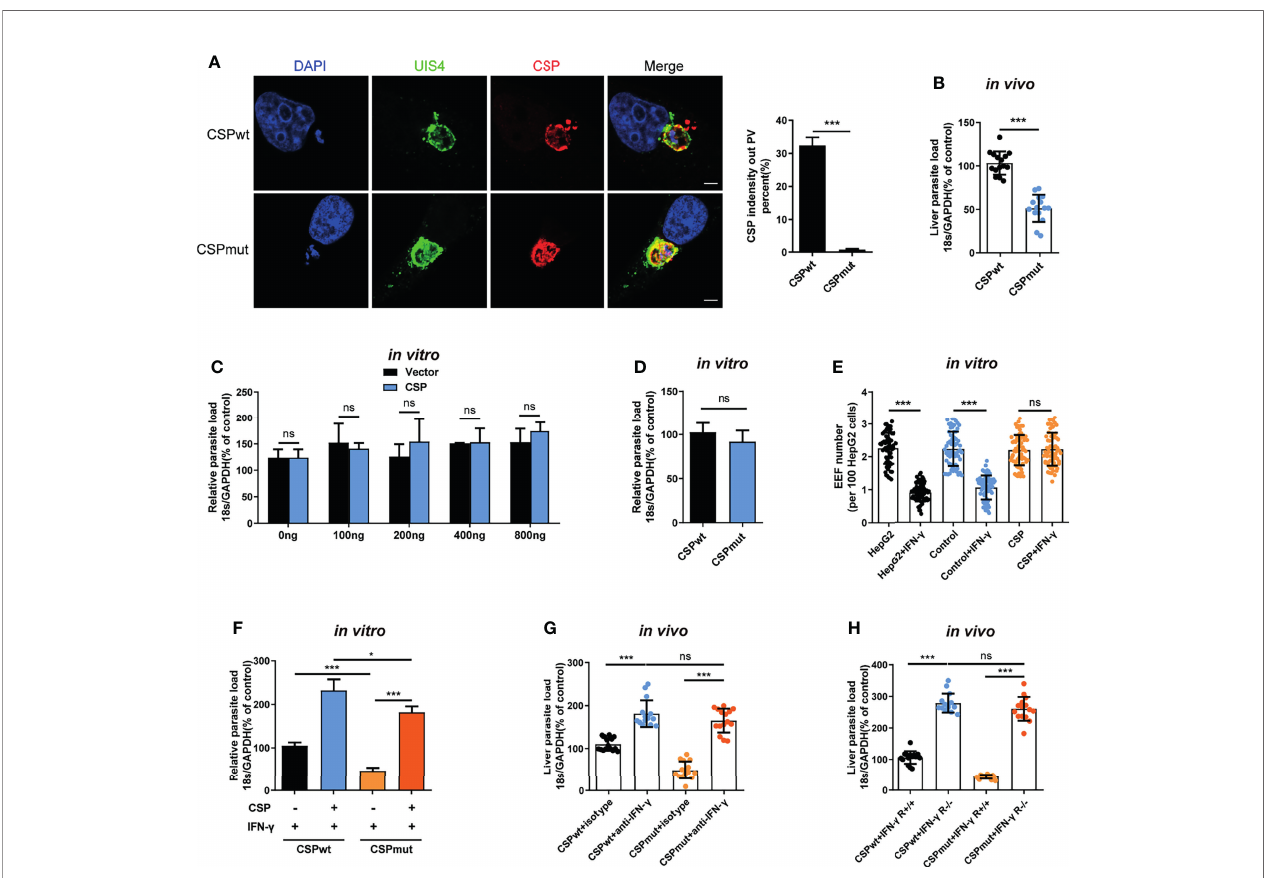
FIGURE 1 | CSP translocated into cytoplasm of hepatocyte mediates the resistance to the killing of EEFs by IFN- g . (A) After 1.2 × 10 5 HepG2 cells were incubated with 4 × 10 4 CSP wt and CSP mut P.b ANKA sporozoites for 24 h, then cells were stained with anti-UIS4, anti-CSP and DAPI. Translocation of CSP of EEFs (n=60) from the PV into HepG2 cytoplasm was observed under confocal microscopy ( left ), and quanti fi ed ( right ). Scale bar =5 m m. (B) After the mice were intravenously injected with 1,000 CSP wt or CSP mut parasite sporozoites for 46 h, the parasite burden in the liver was measured as the ratio of Plasmodium 18S rRNA to mouse GAPDH using Taqman real-time PCR. Each dot represents one mouse (n=15). (C) 1.2 × 10 5 HepG2 cells were transiently transfected with the indicated amount of CSP plasmid and then incubated with 4 × 10 4 CSP wt sporozoites for 46 h; the parasite burden was determined as the ratio of Plasmodium 18S rRNA to human GAPDH using Taqman real-time PCR. Three individual experiments have been performed. (D) After 1.2 × 10 5 HepG2 cells were incubated with 4 × 10 4 CSP wt or CSP mut sporozoites for 46 h, the parasite burden was determined as described in (C) . The experiments have been performed for three times. (E) 1.2 × 10 5 HepG2 (without lentivirus infection), control (infected with Lenti-pCDH control lentivirus and selected by puromycin) and CSP-stably transfected HepG2 cells were pre-treated with or without 1 U/mL IFN- g , and then incubated with 4 × 10 4 CSP wt sporozoites for 46 h. EEF number per 100 HepG2 cells was determined and statistically analyzed. Each dot represents one visual fi eld (n=66, magni fi cation, 630×). (F) 1.2 × 10 5 control and CSP-stably transfected HepG2 cells were treated with 1 U/mL IFN- g , and then infected with CSP wt or CSP mut parasite as above; 46 h later, the parasite burden in hepatocytes was determined and compared as described in (C) . Three individual experiments have been performed. (G) Mice pre-treated with anti-IFN- g or isotype antibody, were infected with 1,000 CSP wt or CSP mut sporozoites. Then, the liver burden of parasite at 46h post infection was determined as described in (B) . Each dot represents one mouse (n=15). (H) IFN- g R1 knockout and WT mice were infected with 1,000 CSP wt or CSP mut sporozoites, and liver burden was determined at 46 h after infection as described as above. Each dot represents one mouse (n=15). The pooled data of three repeated experiments was presented, data are represented as mean ± SD and analyzed by a student ’ s t-test or One- Way ANOVA. ns, not signi fi cant; *P < 0.05; ***P <